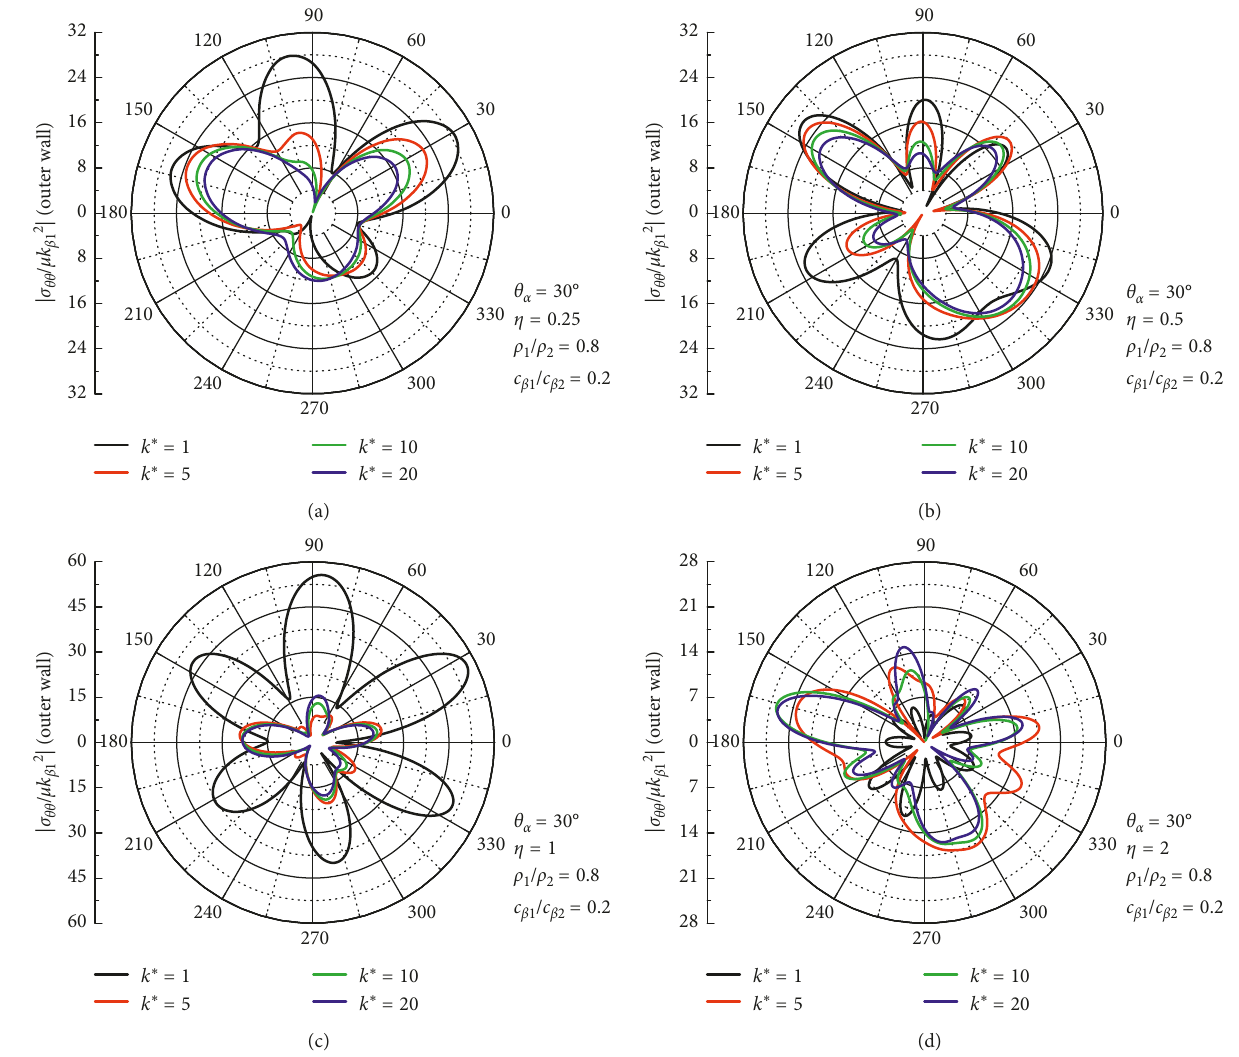
Figure 6: DSCF distribution on lining the outer wall under the incident SV wave ( θ vertical displacement amplitudes of the ground surface near the lining. The standard amplitude displacement above the tunnel lining increases, while the standard amplitude horizontal displacement amplitudes at k 1, 5, 10, and 20 were 2.04, 2.23, 2.29, and 2.32, respectively, while the vertical displacement amplitudes were 1.71, 1.41, 1.27, and 1.16, respectively.